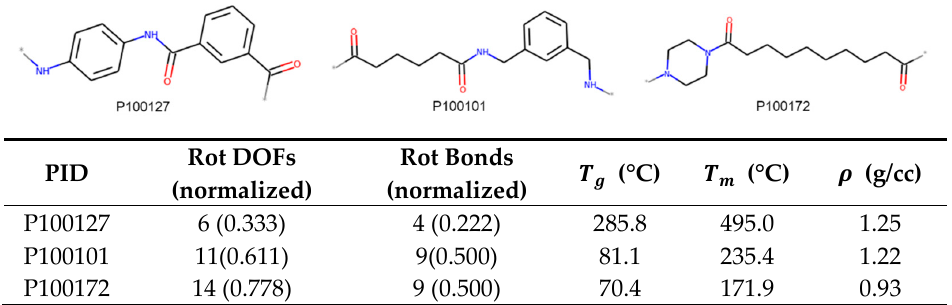
bonds, which are the important features for these properties. We expect that due to higher